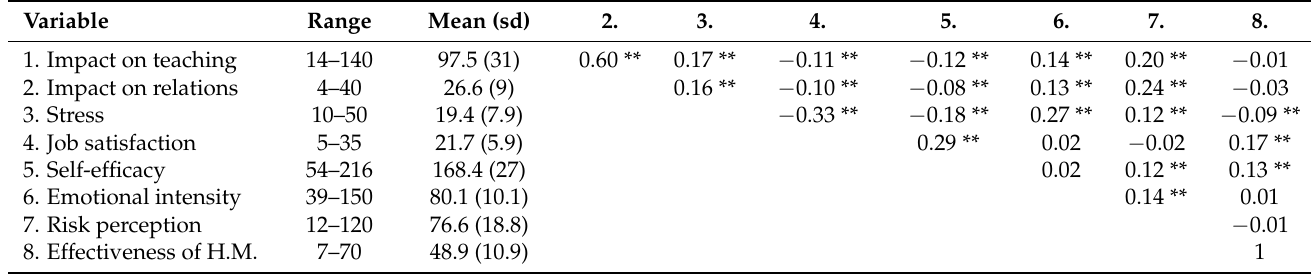
Table 2. Bivariate correlations between